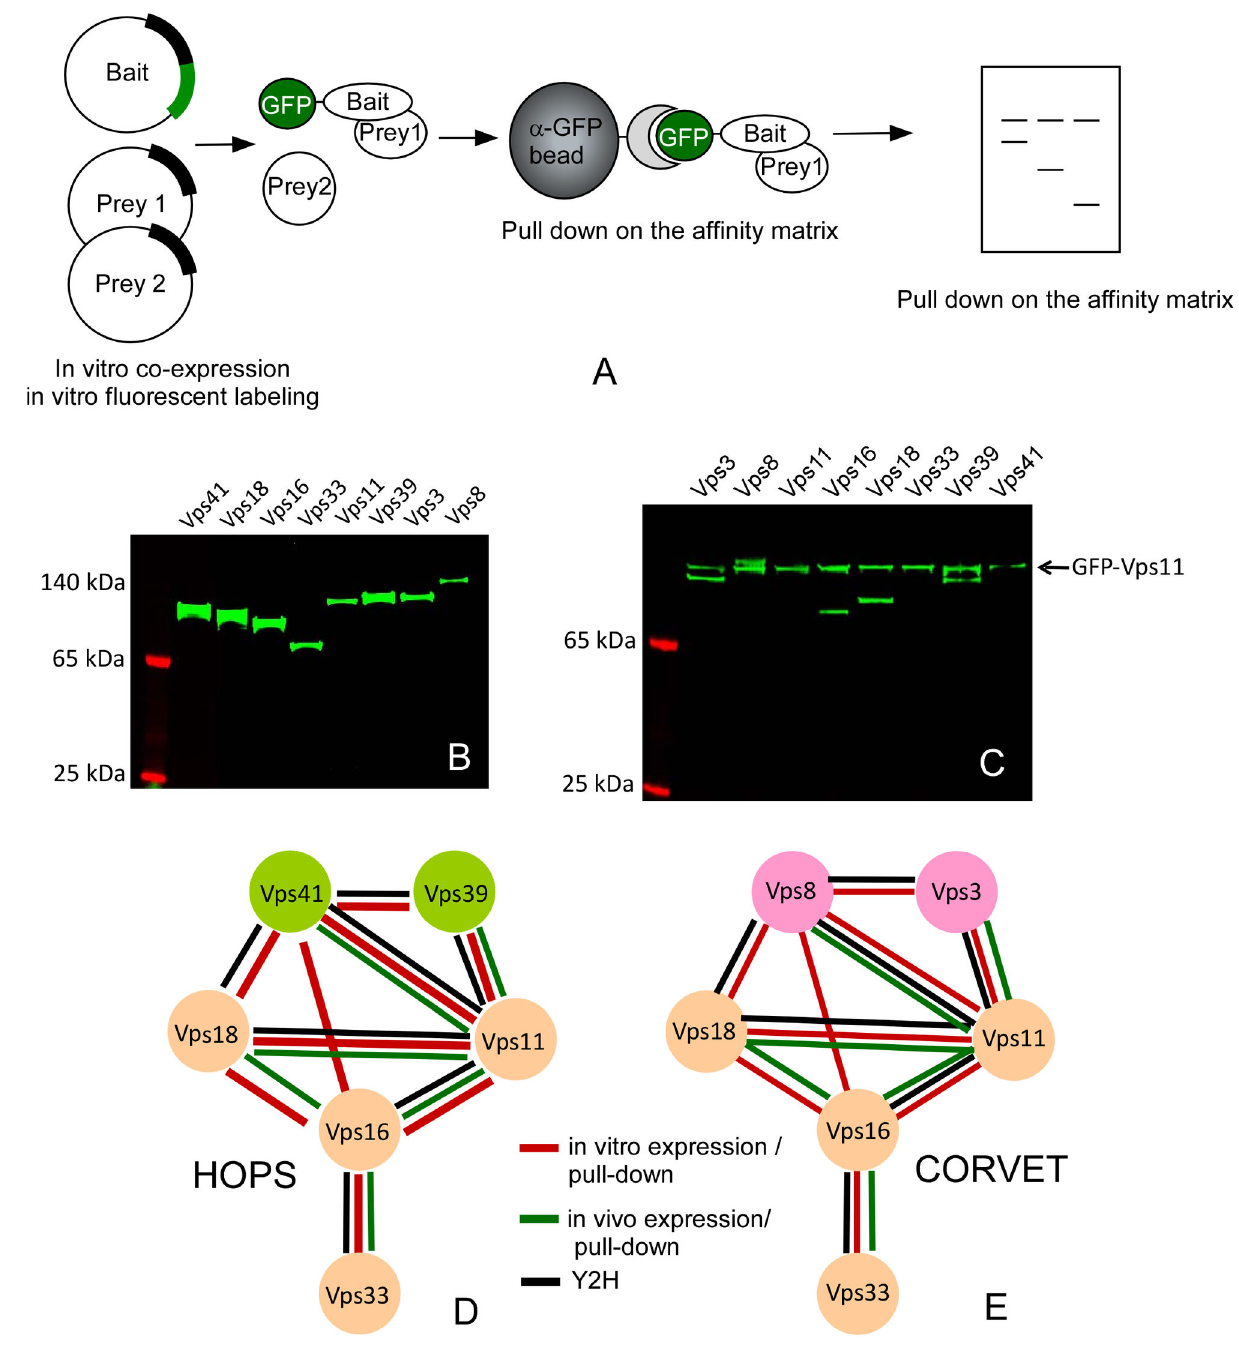
Figure 1. In vitro production of HOPS and CORVET subunits and pull down analysis of the subunit interactions. (A) Schematic representation of the experimental design. (B) SDS-PAGE analysis of the LTE lysate samples expressing individual subunits of the HOPS/CORVET complex. The samples were spiked with BODIPY-Lys-tRNA and the reaction products were visualized by scanning the unstained SDS-PAGE gels. (C) Interactions of Vps11 with other subunits of HOPS/CORVET complex. The GFP-tagged Vps11 was co-expressed with other subunits under conditions described in (B) and GFP-tagged proteins were isolated on the anti-GFP beads, eluted with SDS-PAGE loading buffer and resolved on the denaturing SDS-PAGE. The proteins were visualized by fluorescence scanning. (D) Interaction map of HOPS complex subunits based on the current study (red lines) and literature data (black and green lines). (E) the map of interactions in CORVET complex annotated as in D.